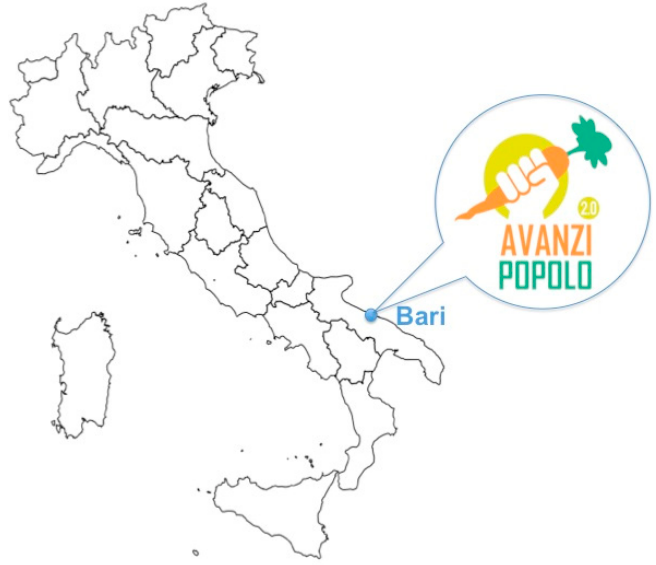
Figure 1. Location and logo of Avanzi Popolo 2.0. Source: own elaboration.